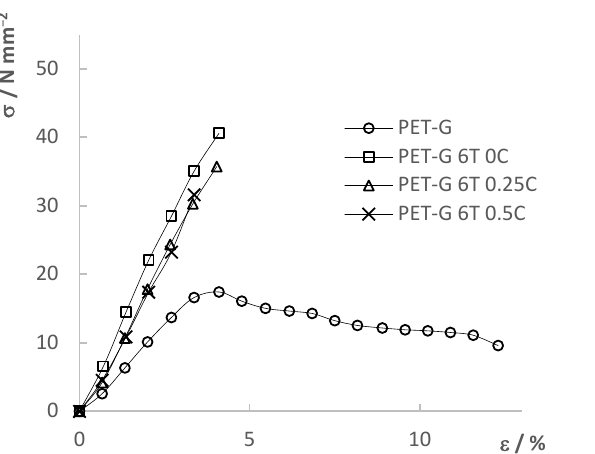
2 composites with added CNT ratios.